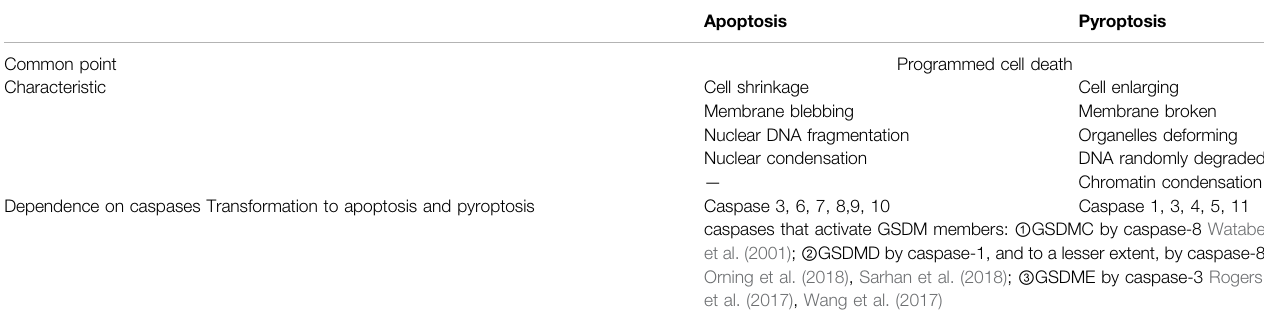
TABLE 1 | Discrimination between apoptosis and